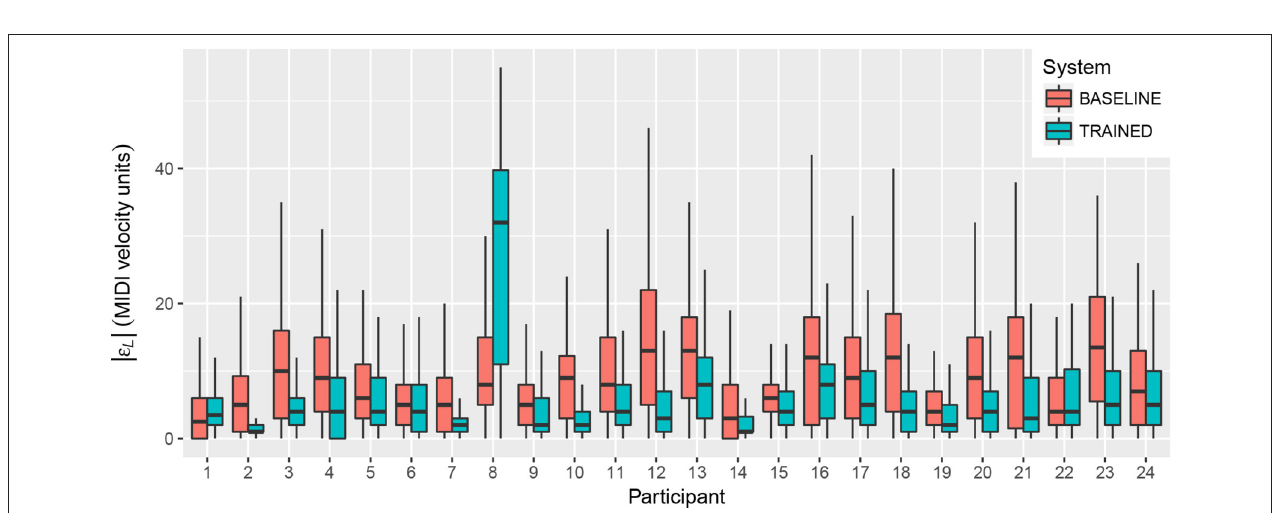
FIGURE 6 | Absolute loudness error ( | ε L | ) for both systems, averaged across tasks, for each